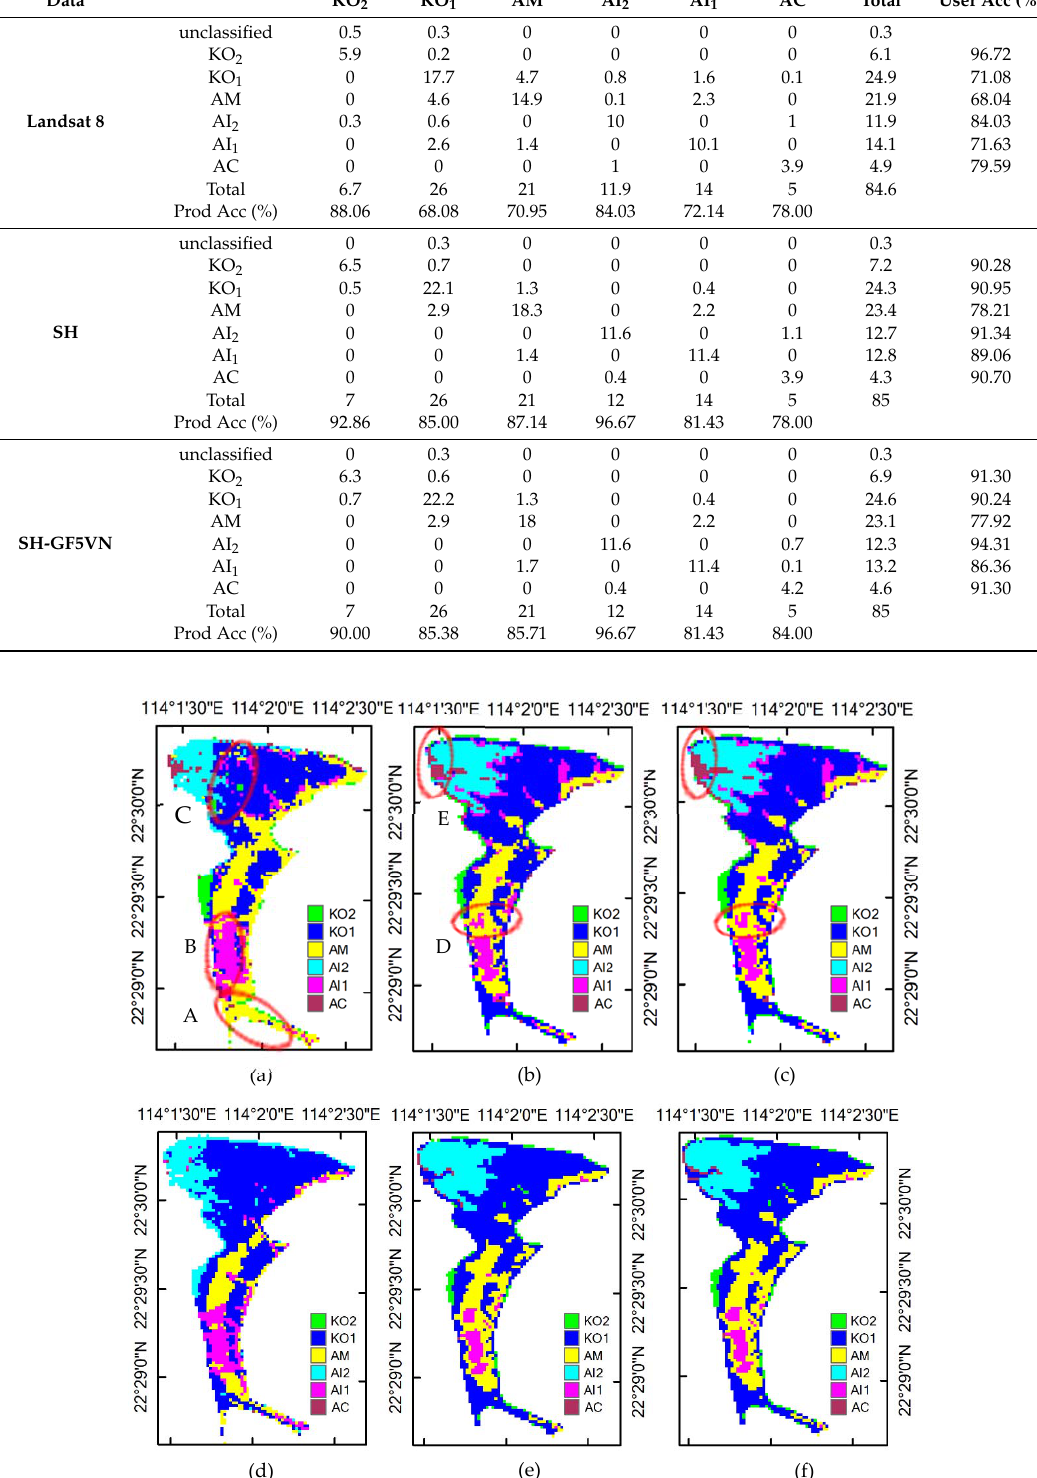
Figure 4. Mangrove mapping using Random Forests with Landsat 8 ( a ), Simulated Hyperion (SH) ( b ) and SH-GF5VN ( c ), and the results using SVM with Landsat 8 ( d ), SH ( e ) and SH-GF5VN ( f ) were demonstrated for comparison. Table 7. The areas of six mangrove species in the Mai Po estimated using Random Forests with SH ‐ GF5VN.